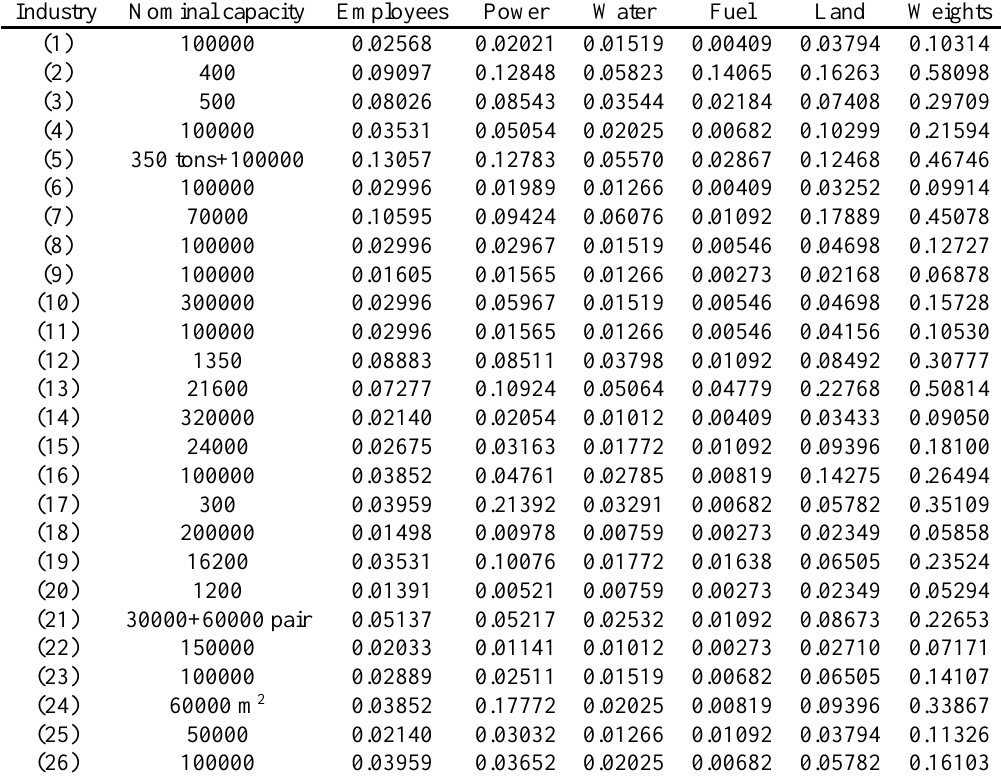
Table 2. Normalized and weighted matrix based on the SAW